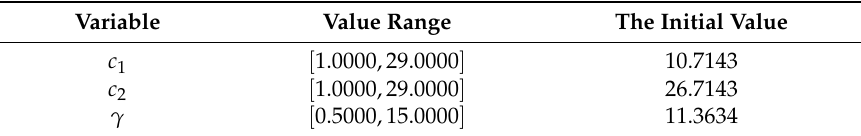
Table 7. Initial estimate results of c 1 , c 2 and γ